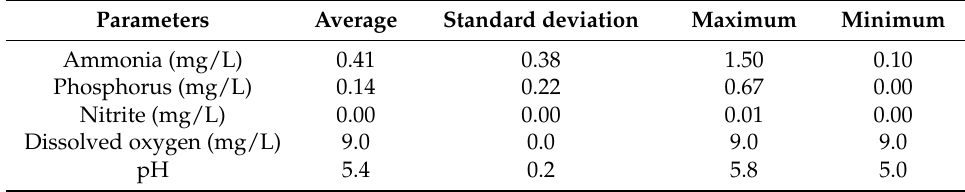
Table 4. Quality of rainwater in the city of Florianópolis based on 18 samples.